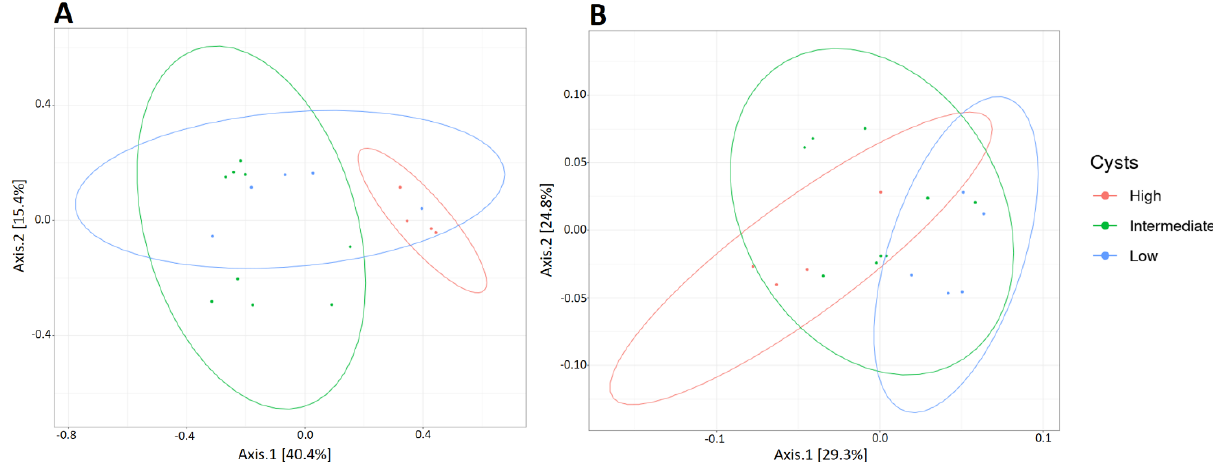
Figure 6. Two-dimensional representation of PCoA plots based on ( A ) Jaccard and ( B ) unweighted Unifrac beta diversity of 16S rDNA genes. Each dot represents a sample, and each color represents a collection time: D−8 (red), D42 (green), and D85 (blue). Axis 1 is the principal coordinate component causing the largest difference in samples, with an explanatory value of 40.4% for Jaccard and 29.3% for Unifrac. Axis 2 was next, with an explanatory value of 15.4% for Jaccard and 24.8% for Unifrac.